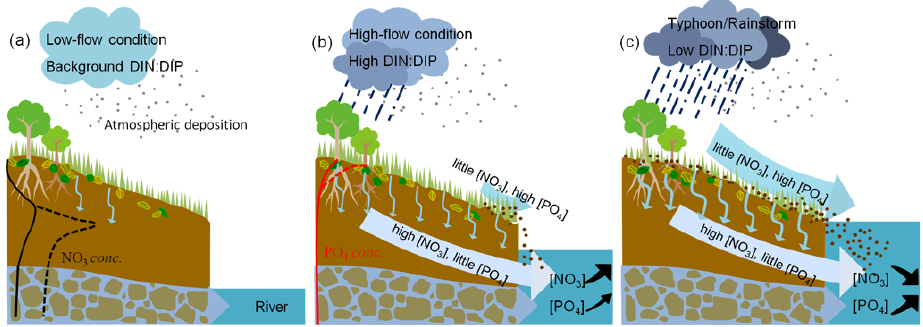
Fig. 9. The schematic diagram of the conceptual model illustrating nutrient export in (a) low-flow condition and dry season; (b) high-flow condition; (c) typhoon and rainstorm flood condition. The arrow size represents the runoff amount. [ ] denotes concentration. The increase or decrease of concentration and its significance was marked. NO 3 (black line) and PO 4 (red line) concentrations in the soil profile of pristine (solid line) and cultivated (dashed line) land are